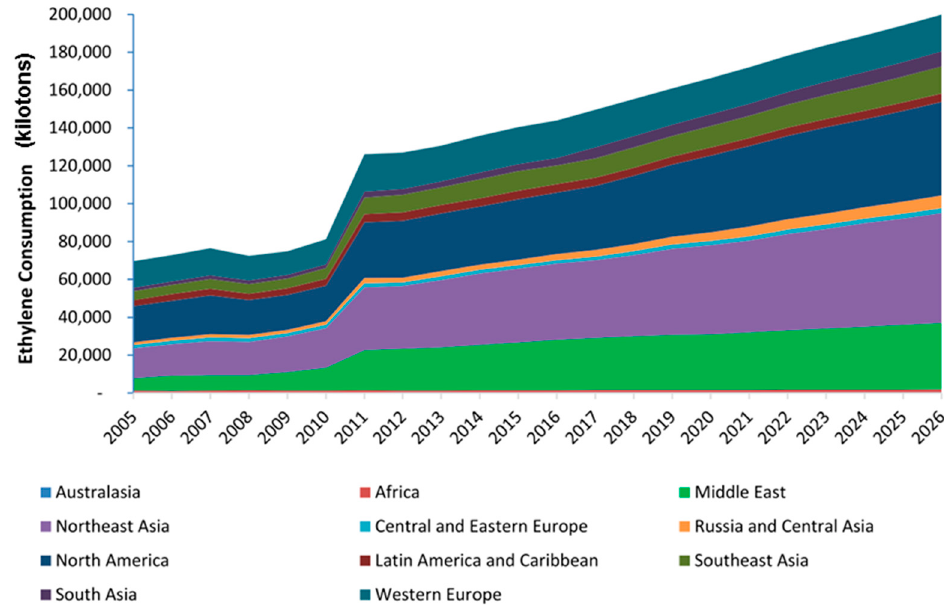
Figure 1. Global ethylene demand is expected to grow to almost 200 megatons by 2026.